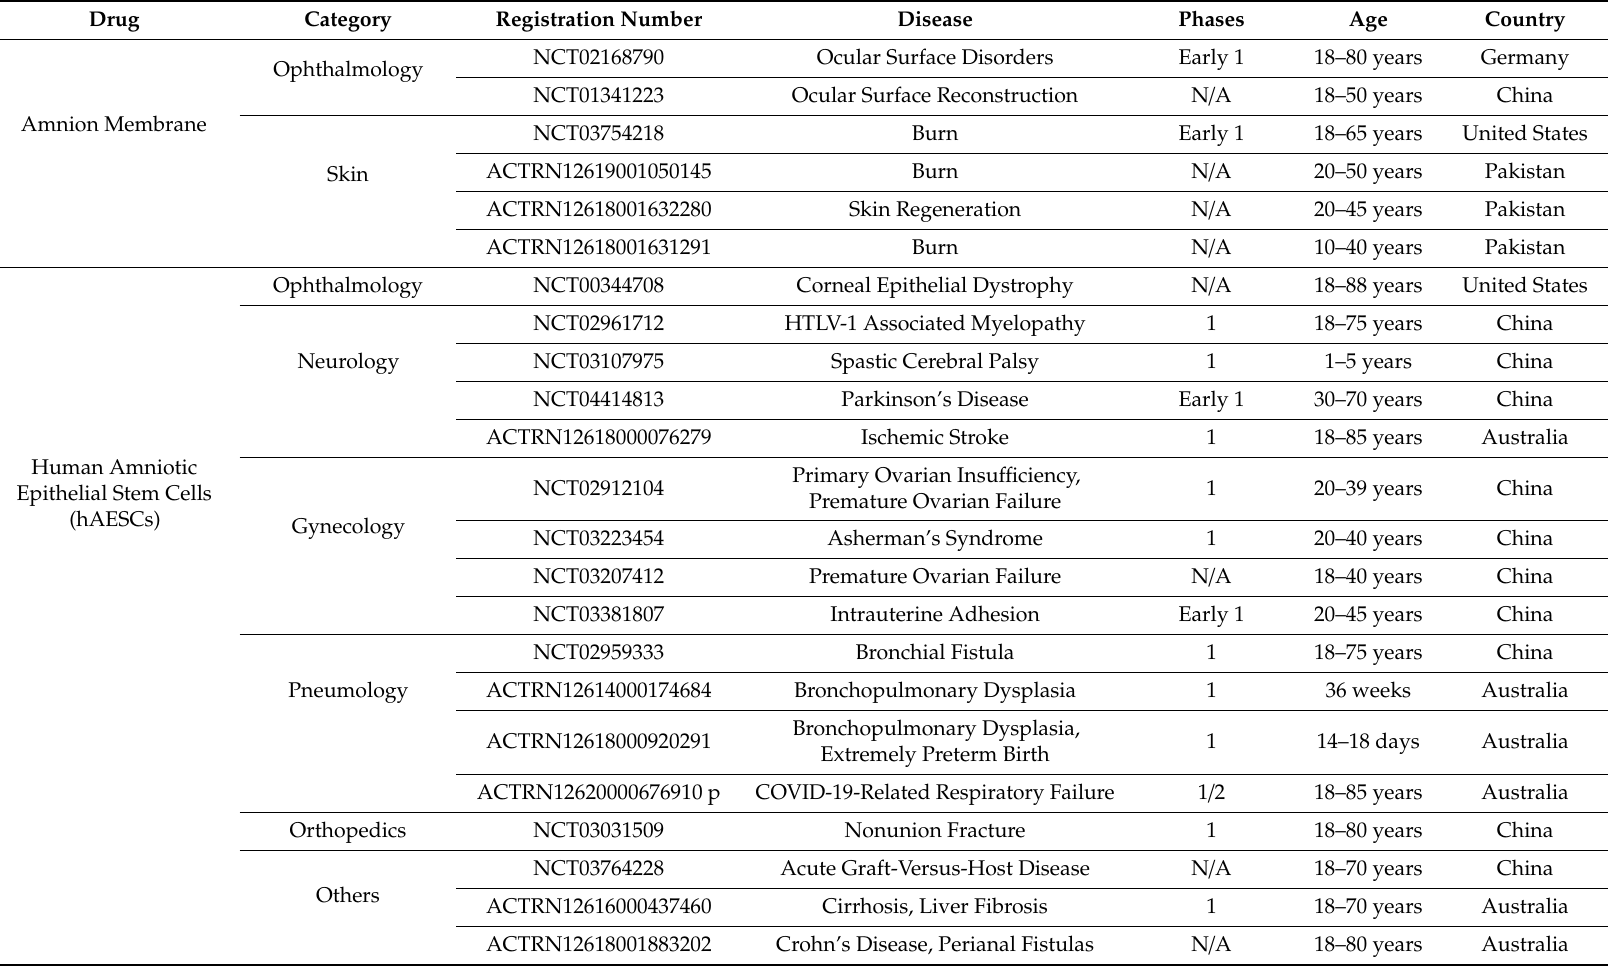
Table 3. Clinical trials utilizing amnion membrane and hAESCs as biological